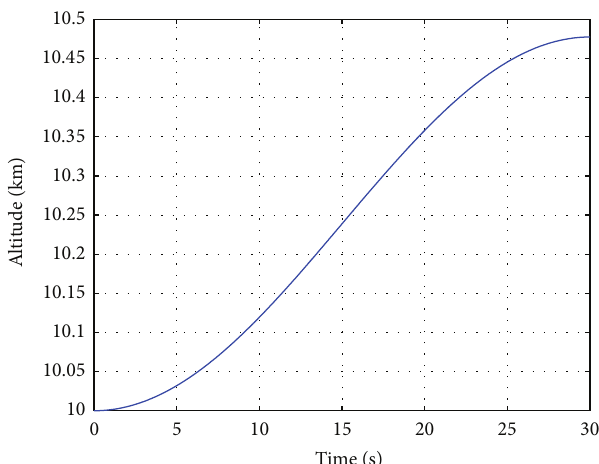
Figure 2: The target’s track in the altitude direction.